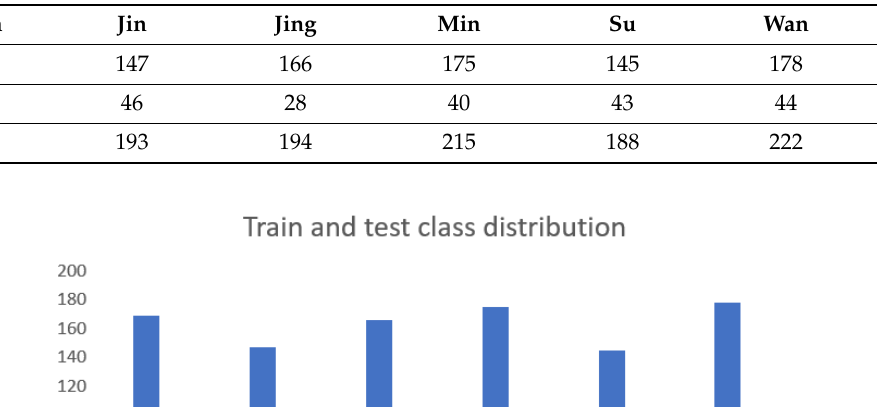
Table 3. Training and test set of our architectural style dataset.